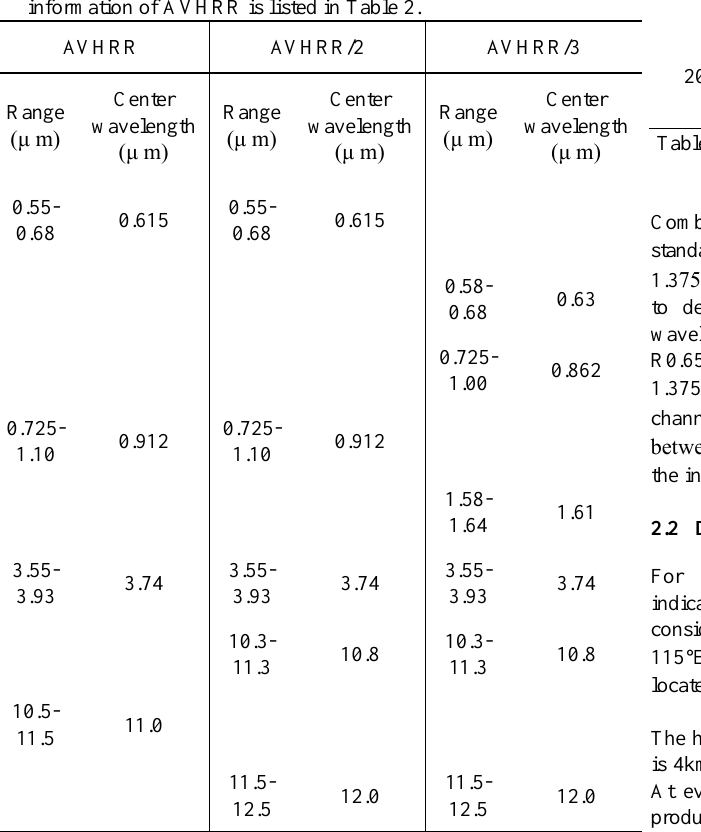
Table 2. Range and center wavelength of each channel on AVHRR, AVHRR/2, AVHRR/3